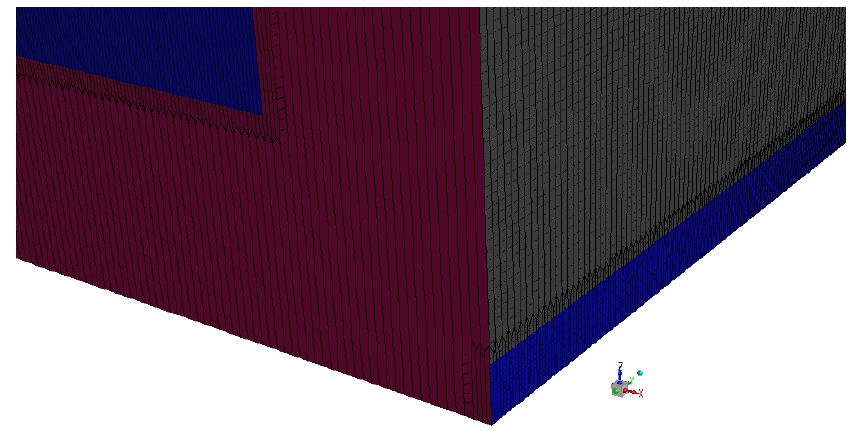
Figure 6. Room volume mesh. In blue, the room